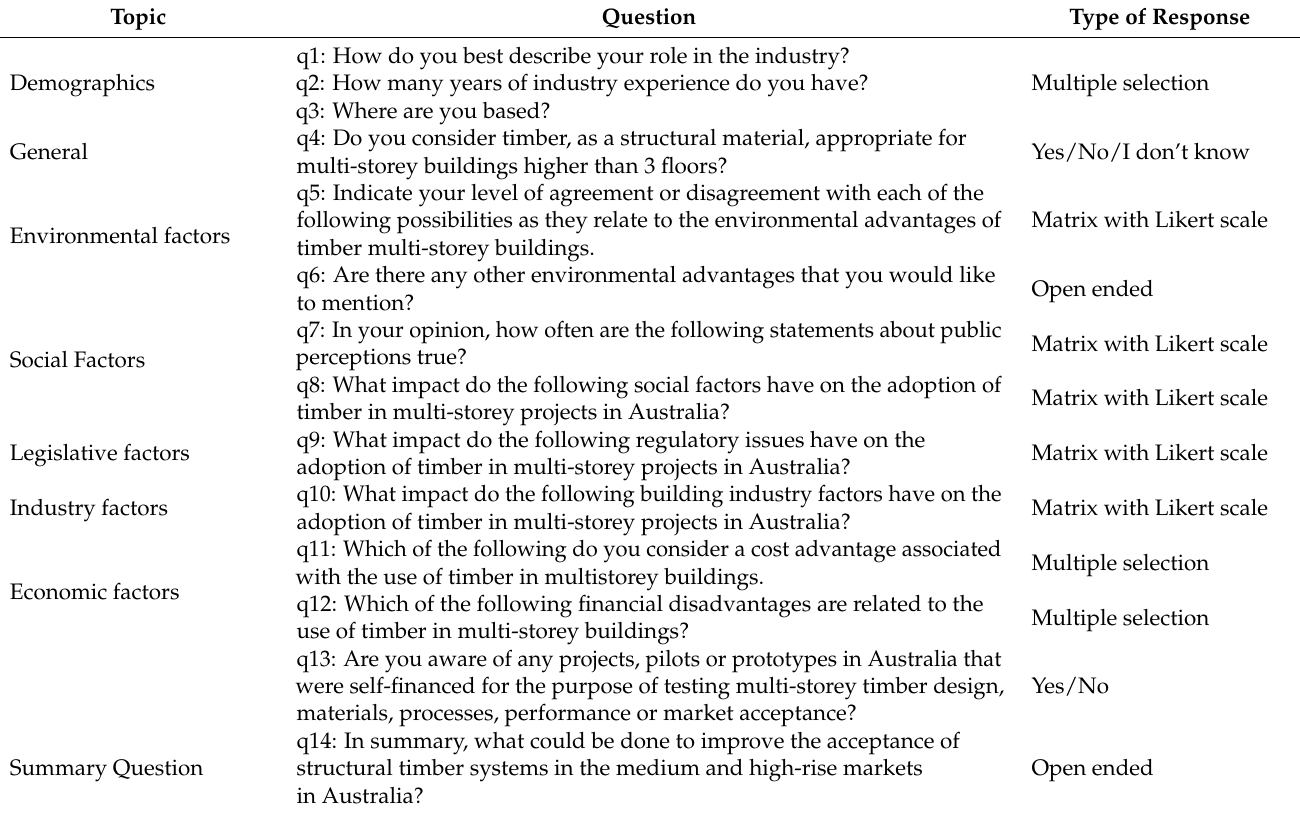
Table A1. Summary of Survey